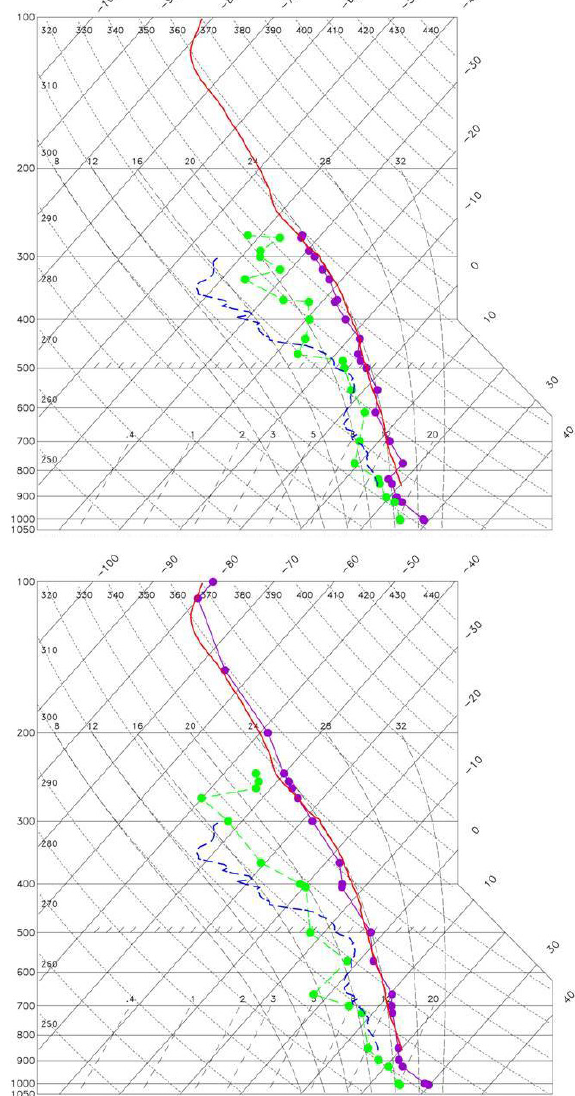
Fig. 20. CHAMP soundings compared to two radiosondes in Ty- phoon Toraji (2001). The CHAMP temperature and water vapor profiles are computed from the observed refractivity and a 1D-VAR algorithm (Anthes et al.,